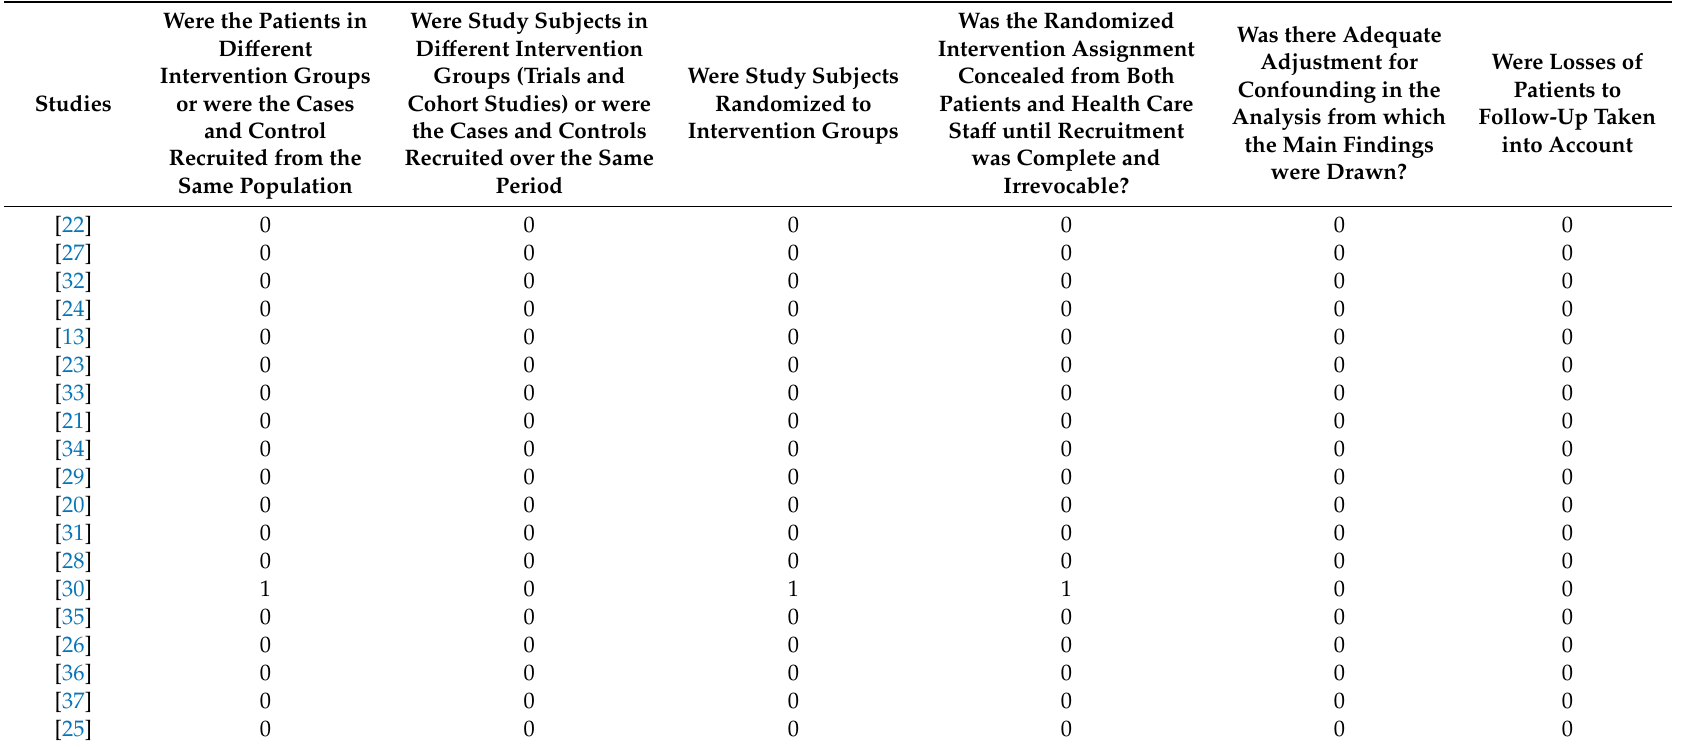
Table 6. Summary of the checklist for measuring internal validity-confounding (selection